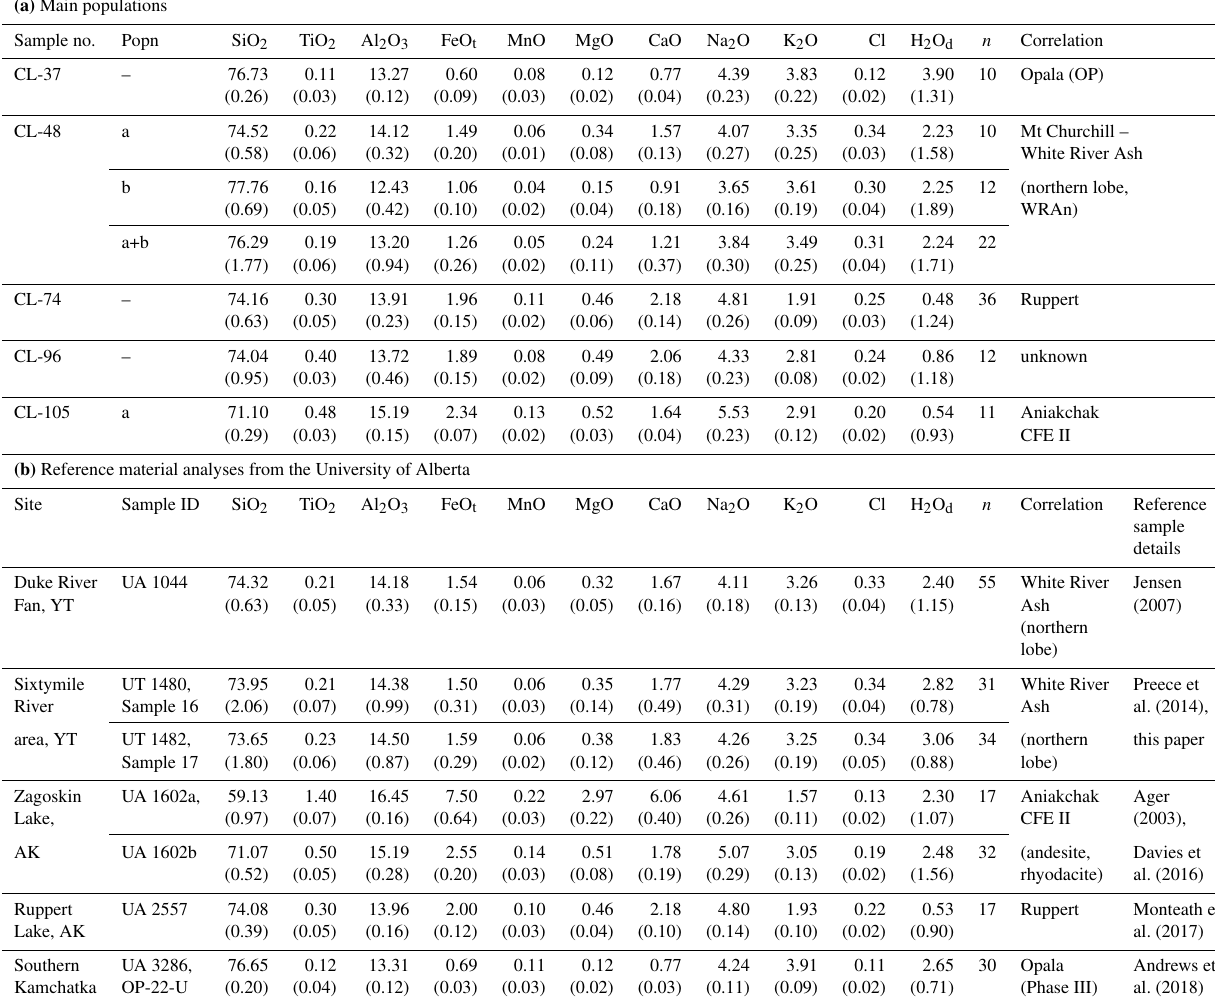
Table 2. Normalised average major-element geochemical glass data for identifiable populations of analysed tephra samples and suggested correlations. Popn: unimodal geochemical data are labelled as “–”; where multiple geochemical populations are identified, they are labelled separately (e.g. a, b), but if they are interpreted as being related heterogenous populations a combined average is also shown (e.g. a+b). FeO t : total iron oxide as FeO; H 2 O d : water by difference; numbers listed in brackets: 1SD. (a) Main populations. (b) Reference material analysed at the University of Alberta; for full details regarding the original sample details please see listed references. (c) Samples with multiple populations or too few points to use as tie points. Only groups of three or more analyses are shown here – for full details see Table